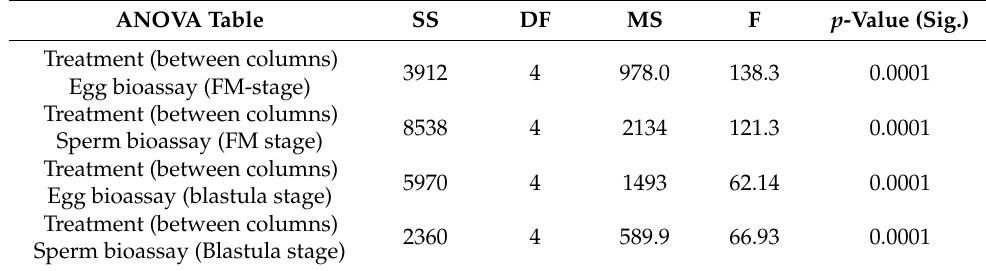
Table 2. ANOVA for FM and blastula stage (egg and sperm